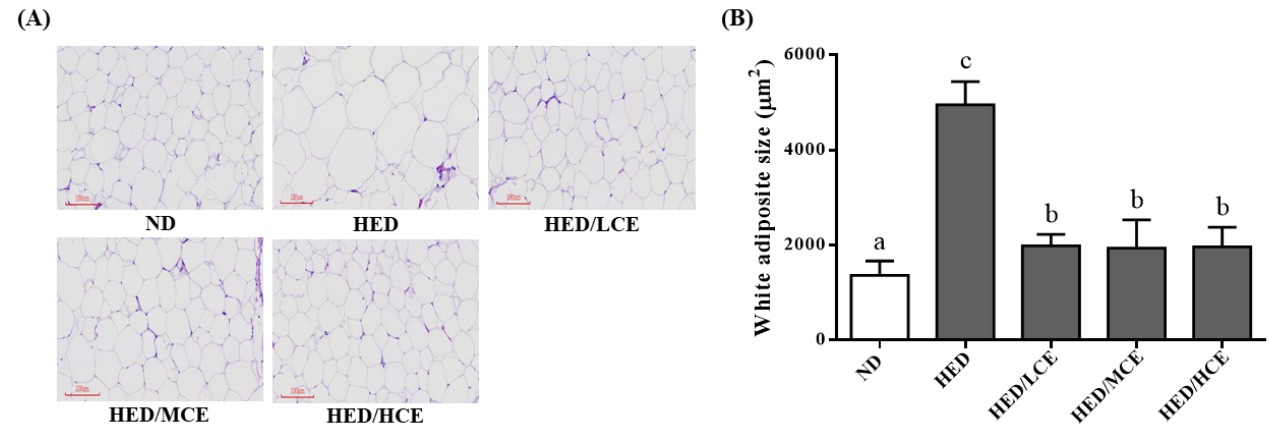
Figure 5. Effect of phlorotannin-rich extracts from A. nodosum and F. vesiculosus on ( A ) hematoxylin and eosin staining and ( B ) mean adipocyte size of epididymal white adipose tissue in rats with high- energy diet–induced hyperlipidemia. ND: normal diet; HED: high-energy diet; LCE: low dosage of crude extract; MCE: medium dose of crude extract; HCE: high dosage of crude extract. Values were presented as means ± SD (n = 10). Data were statistically analyzed through one-way ANOVA fol- lowed by a Duncan post hoc test. Different letters and symbols indicate significant differences ( p < 0.05).